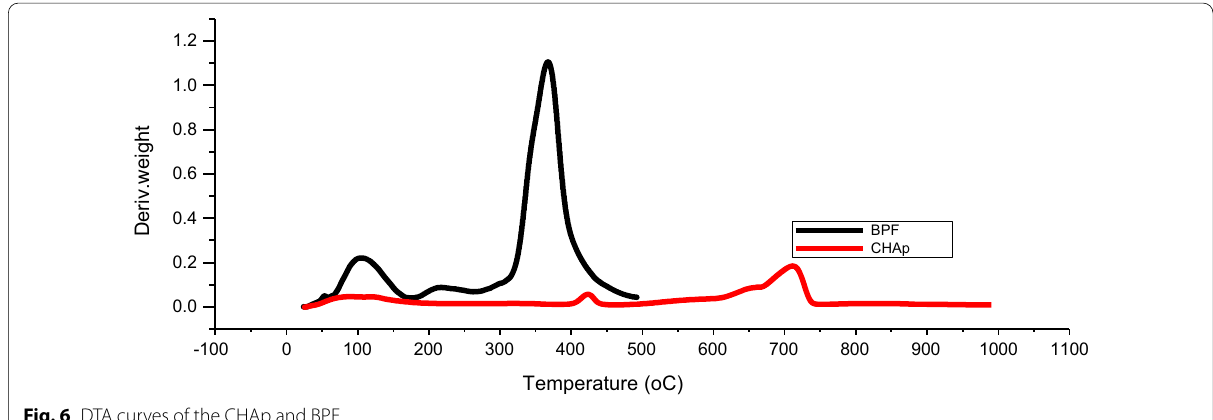
Fig. 6 DTA curves of the CHAp and BPF